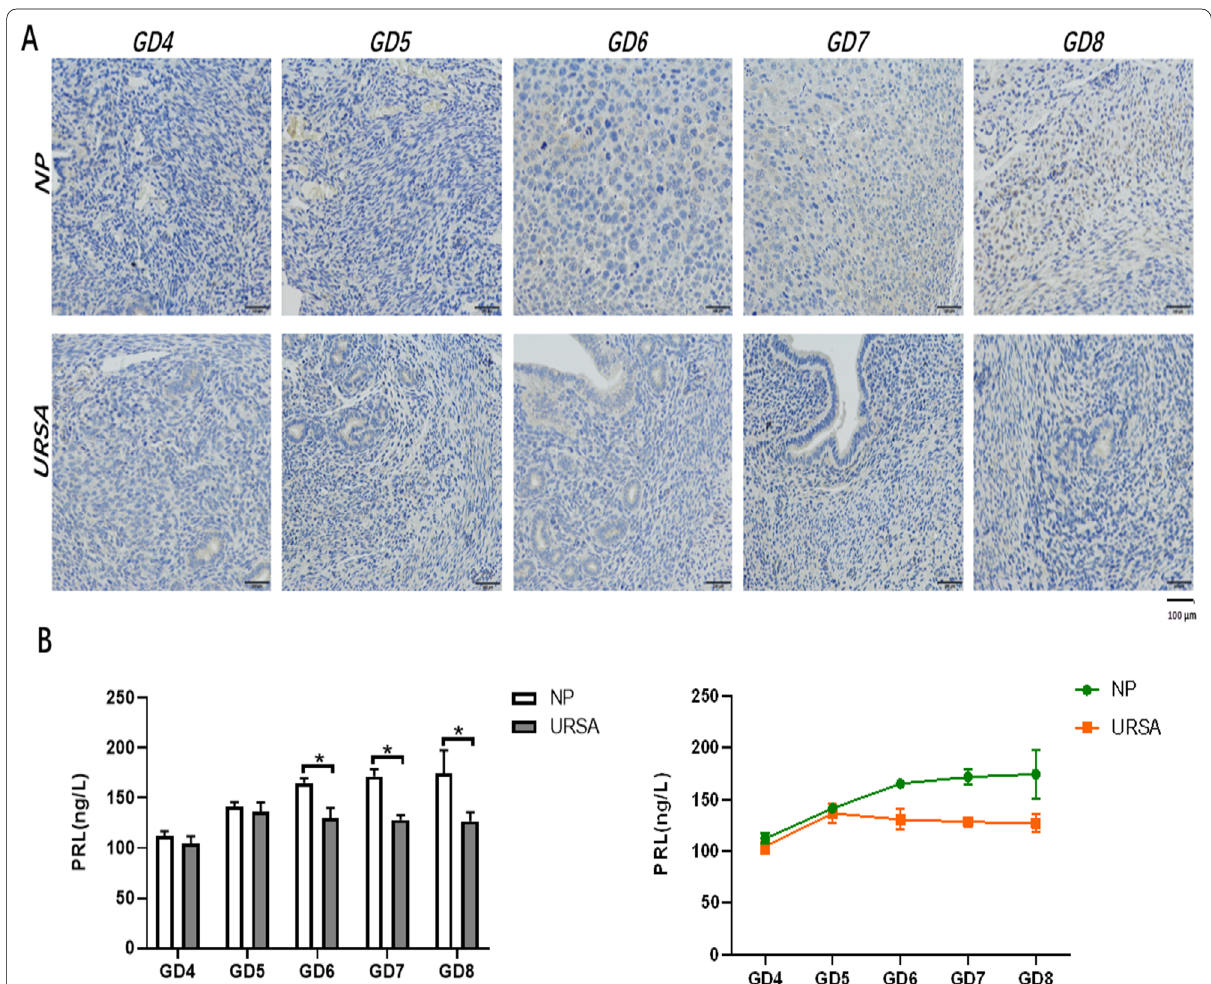
Fig. 2 The Temporal changes of PRL quantification in decidual tissues of NP and URSA groups (mean SD). A Immunostaining for PRL on ± GD4‑GD8. Brown staining indicates positive signals. Nuclei are counterstained with dark brown. The magnifications in the upper panels are at 200 . Scale bar, 100 μm; B The histogram on the left shows the difference in PRL levels by ELISA test in decidual tissues between the two groups × on GD4‑GD8. (n 5 in B ). Results are shown as the mean SD. * Significantly different (p < 0.05). The line chart on the right shows the temporal = ± changes of PRL levels. Unit (ng/L) means protein